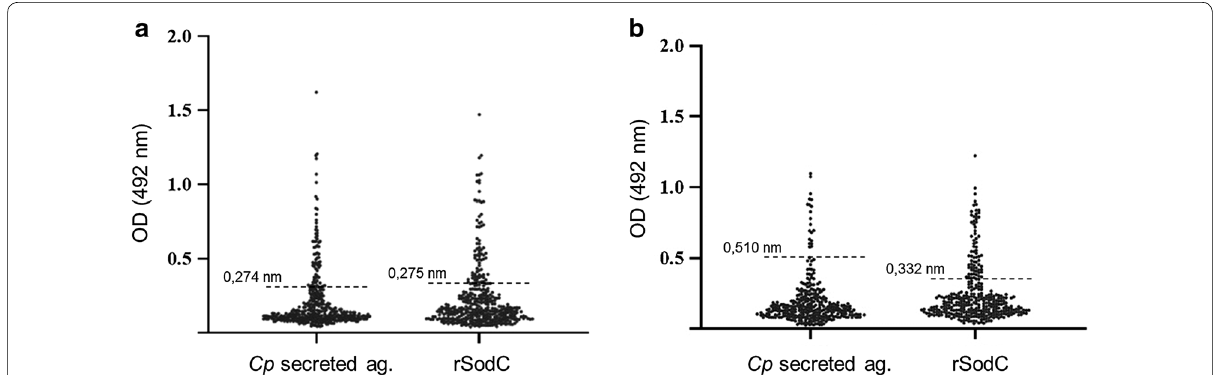
Fig. 3 Distribution of OD results using rSodC protein and secreted C. pseudotuberculosis antigen from goat ( a ) and sheep ( b ) field samples. The graphs show the OD values obtained for each goat and sheep sample evaluated. The lines in the graphs represent the cut-off value for each